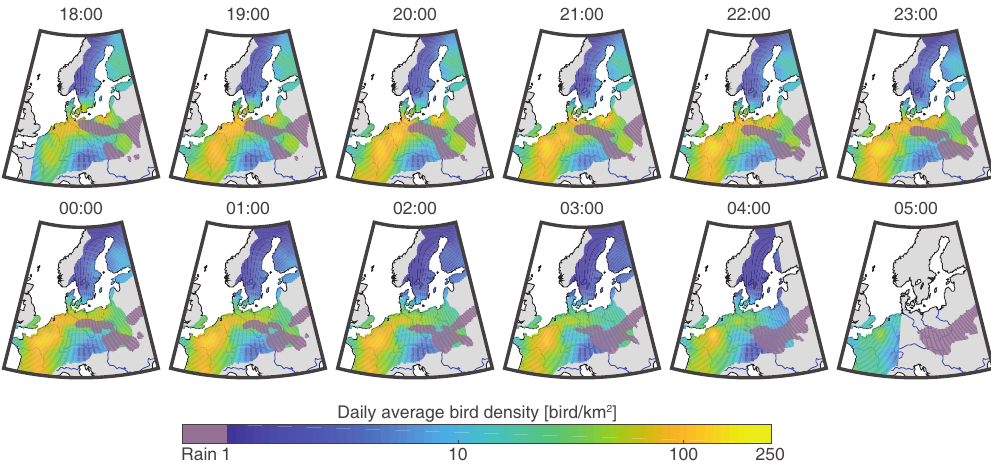
Figure 5. Maps of bird density estimation every hour of a single night (3–4 October). The sunrise and sunset fronts are visible at 18:00 and 05:00 with lower densities close to the fronts and no value after the front. The resemblance from hour-to-hour illustrates the high temporal continuity of the model. A rain cell above Poland blocked migration on the eastern part of the domain. In contrast, a clear pathway is visible from Northern Germany to Southwestern France.